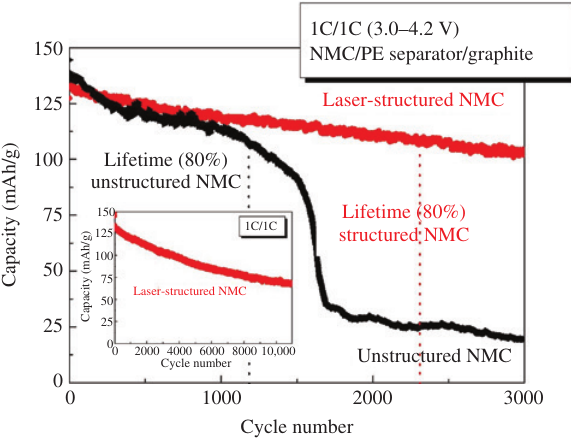
Figure 26: Specific discharge capacities of pouch cells with unstructured and structured NMC cathodes for cycle numbers up to n = 3000 cycles and 10,000 cycles (inset diagram),